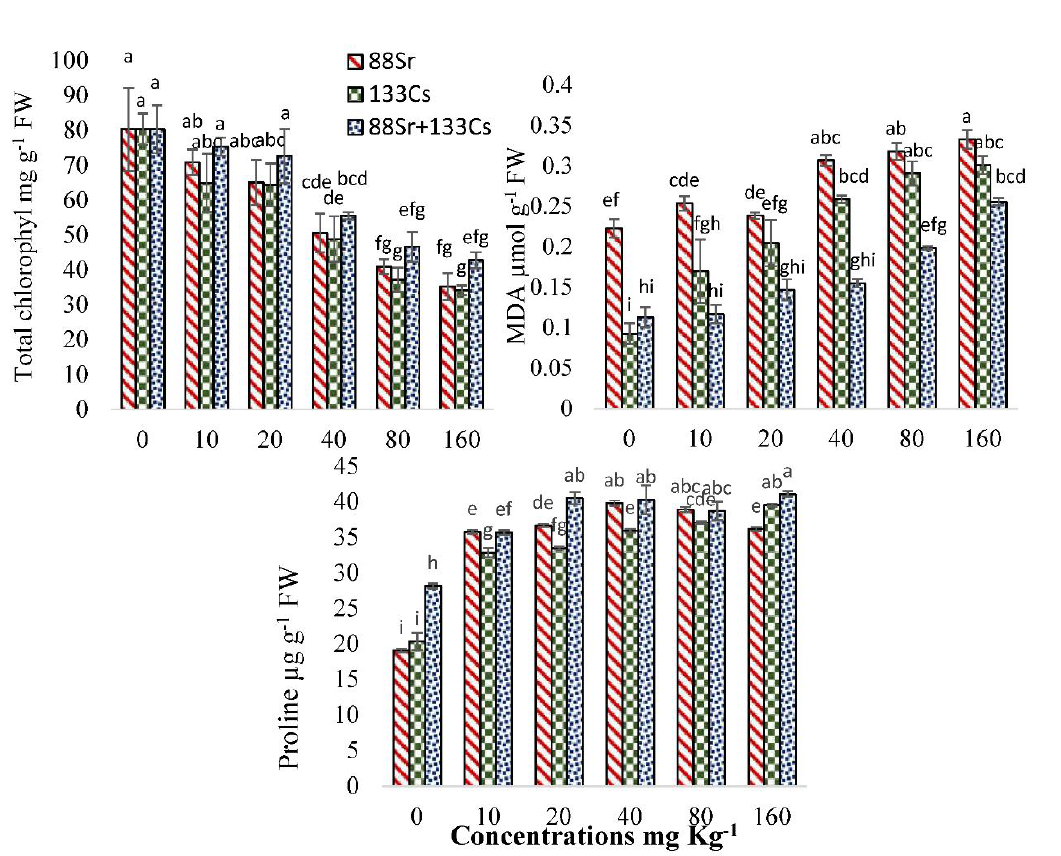
Figure 2. The effect of 88 Sr, 133 Cs, and 88 Sr + 133 Cs stress on the chlorophyll, MDA, and proline content of cucumber to various concentrations (0 to 160 mg kg −1 ) of 88 Sr, 133 Cs, and 88 Sr + 133 Cs treatments. The columns sharing different letters are significantly different at p < 0.05.